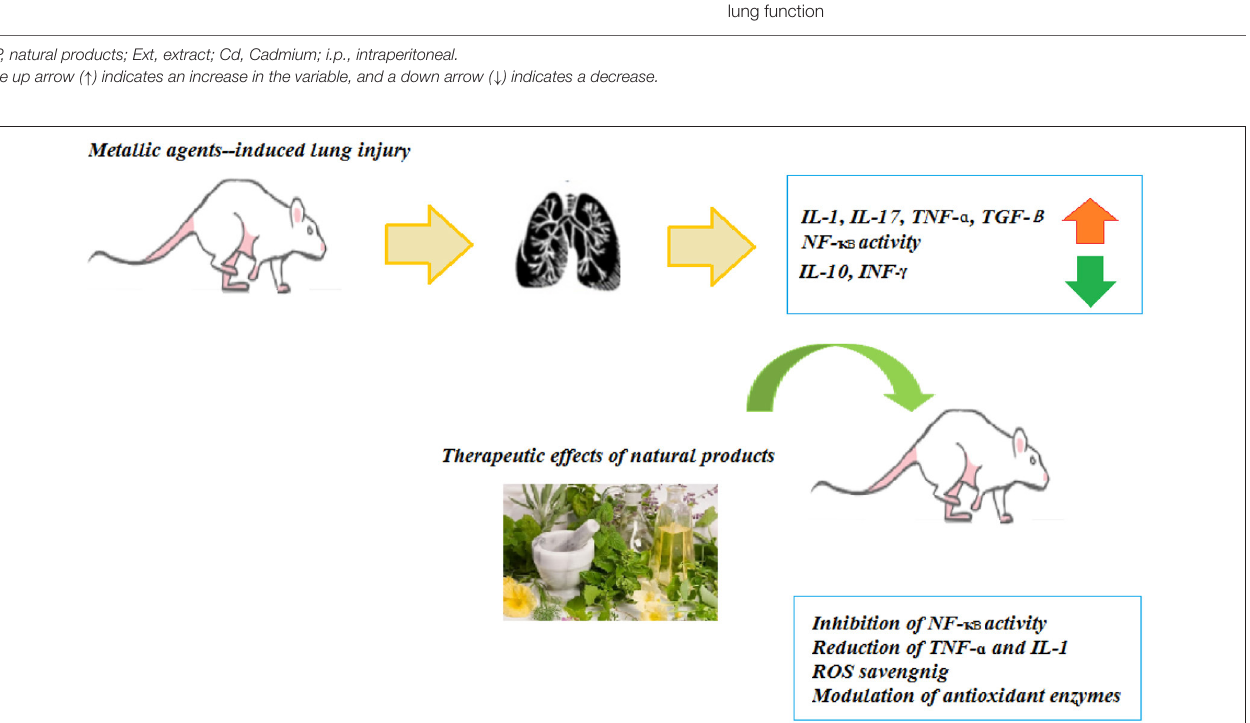
FIGURE 3 | Inhibitory effects of NP on metallic agents-induced pulmonary